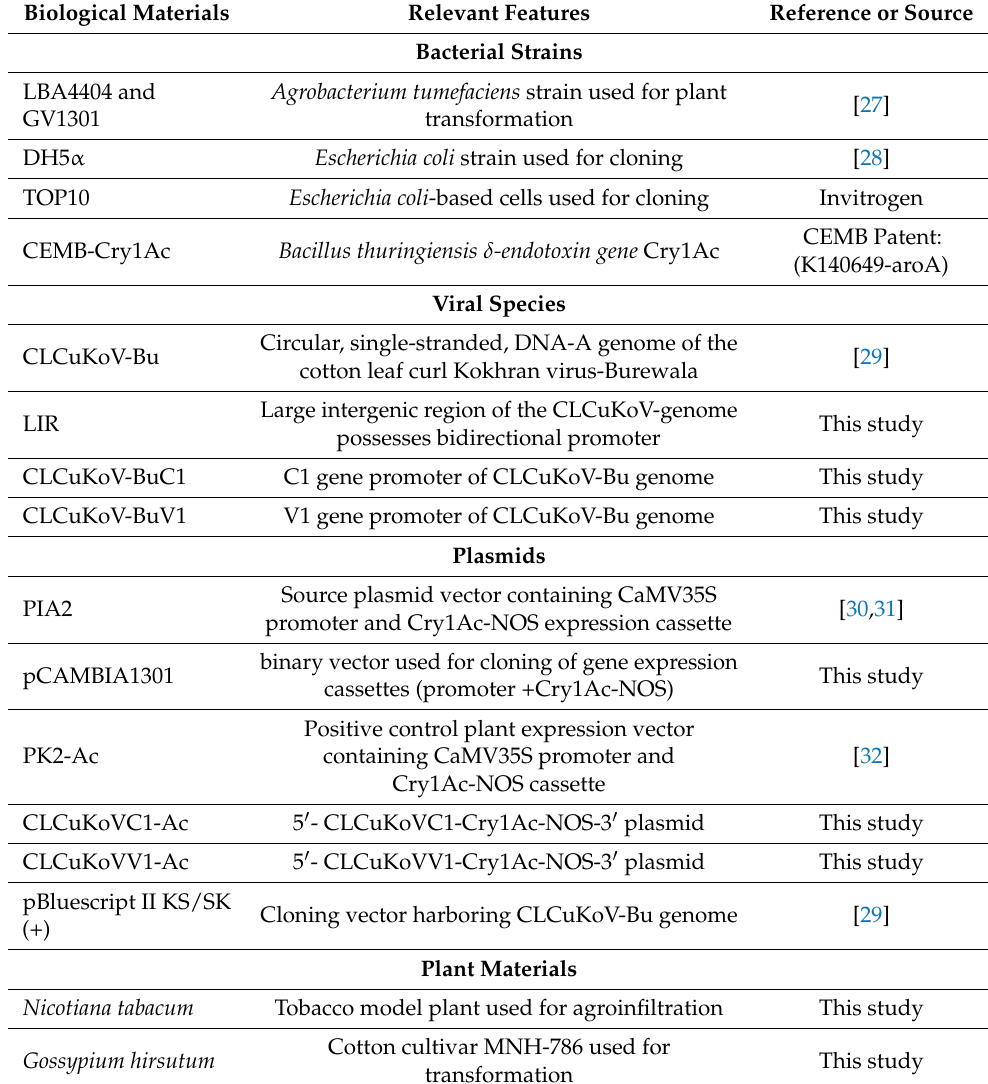
Table 1. Bacterial strains, viral species, plasmid vectors and plant